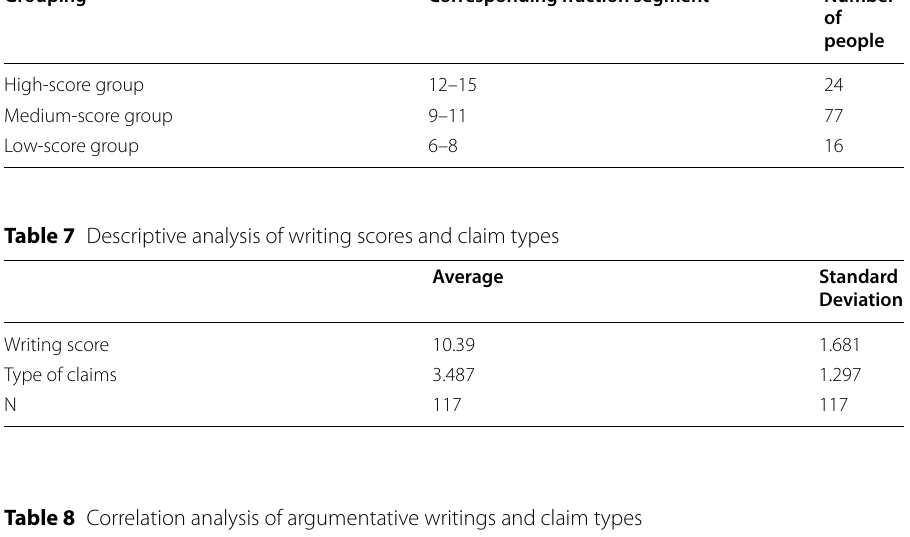
Table 8 Correlation analysis of argumentative writings and claim types